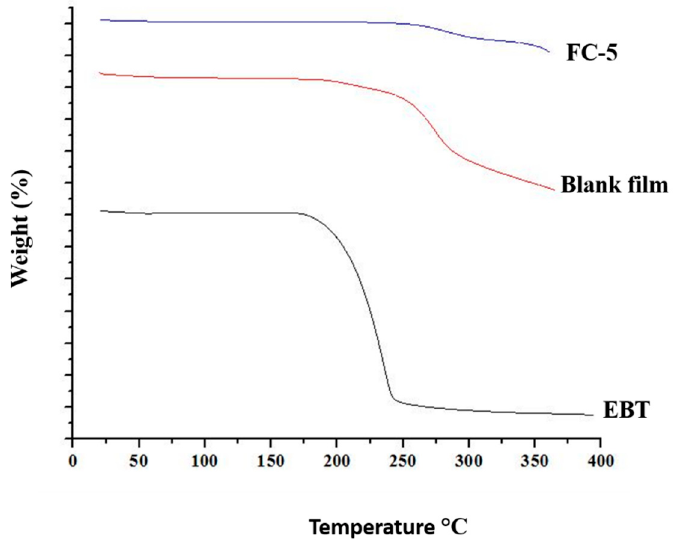
Figure 6. Thermograms of pure EBT, blank film, and EBT micelles-loaded orodispersible sublin- gual gual film.